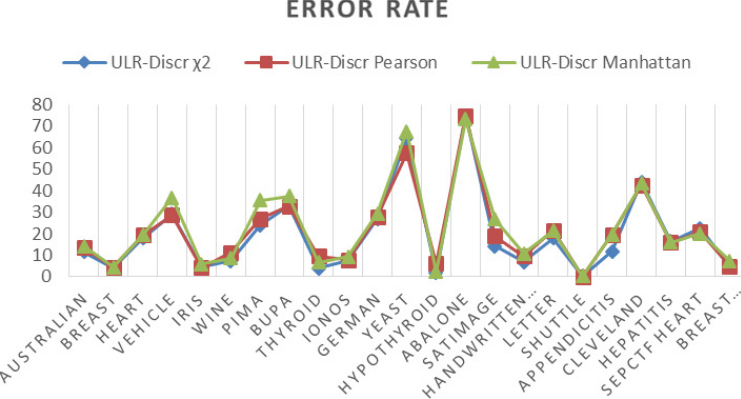
Fig. 4. Comparing error rates for ULR-Discr using (cid:1) 2 , the coe±cient of Pearson and the distance of